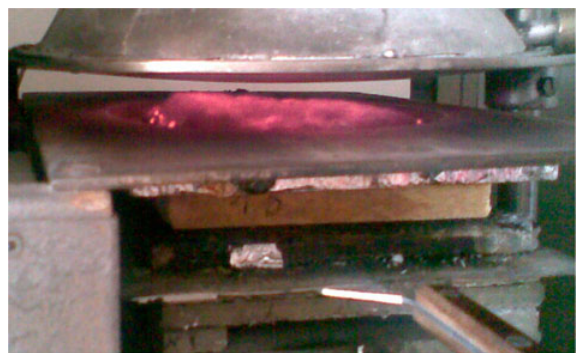
Fig. 3. Image of the intumescent protective layer which is formed during the test